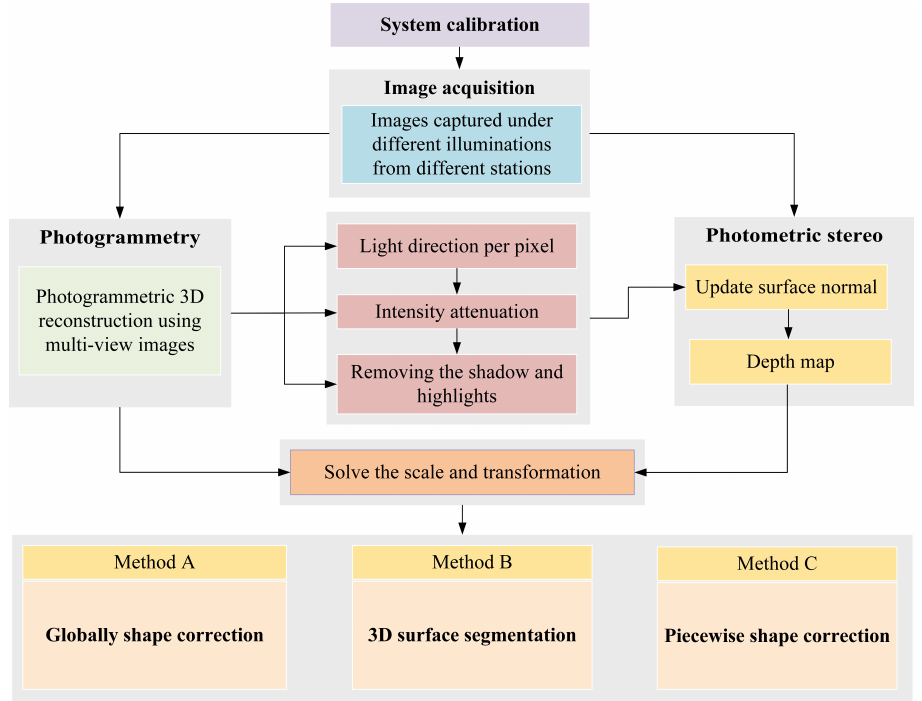
Figure 3. The general overview of the proposed integration with its three